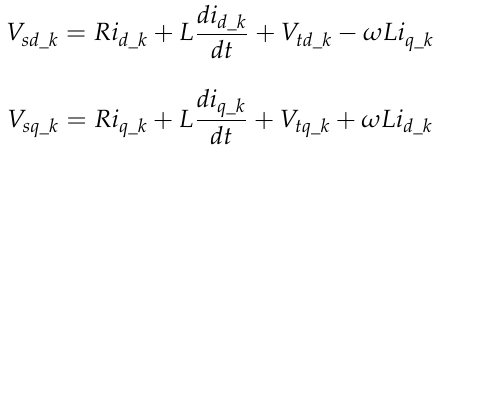
Figure 5. Circuit diagram of the proposed MVDC system .